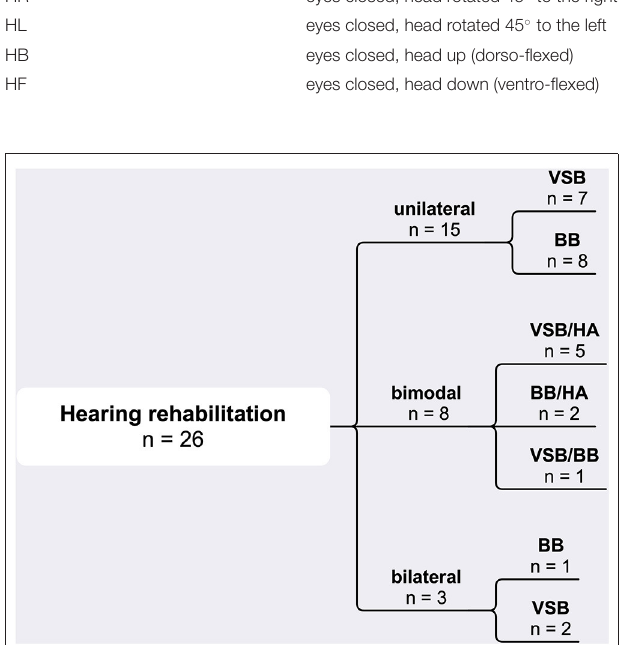
FIGURE 2 | Overview of hearing rehabilitation modalities. BB, Bonebridge; HA, hearing aid; VSB, Vibrant Soundbridge.